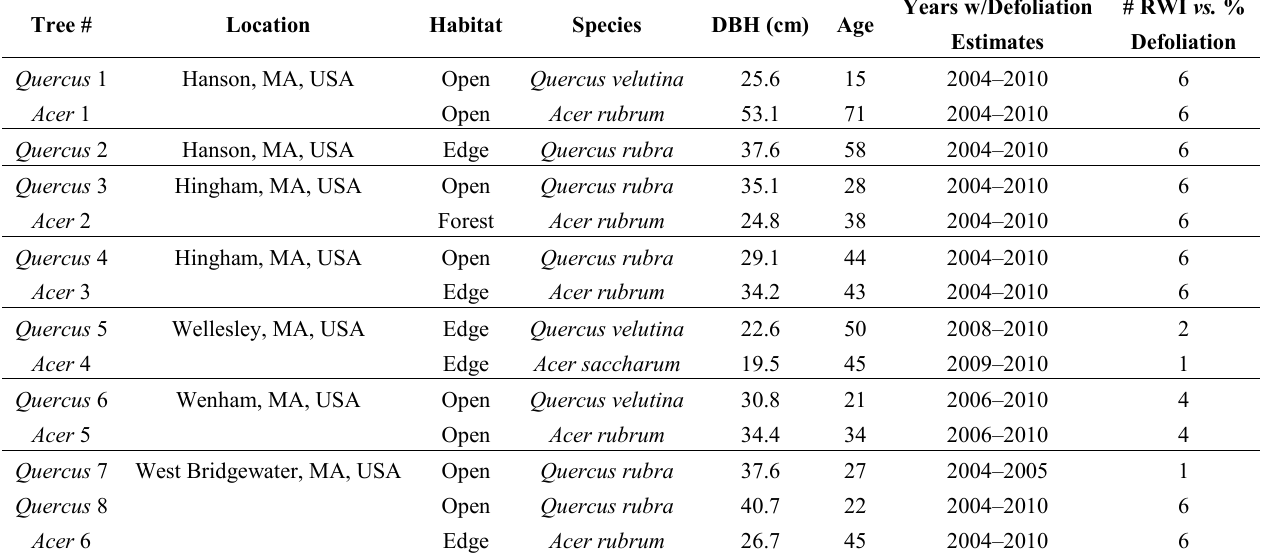
Table 1. Location, habitat (open grown, forest, forest edge), species, diameter at breast height (DBH; 1.4 m), age, years of winter moth defoliation estimates of ―defoliation trees‖ and the number of ring width index (RWI) values (calculated using detrending method; see methods Section 2.3) with corresponding percent defoliation estimates in eastern Massachusetts, USA. Number of RWI values vs. % defoliation estimates determined by subtracting the first year of defoliation estimates per tree in order to match models evaluating previous year defoliation estimates (see Methods section for